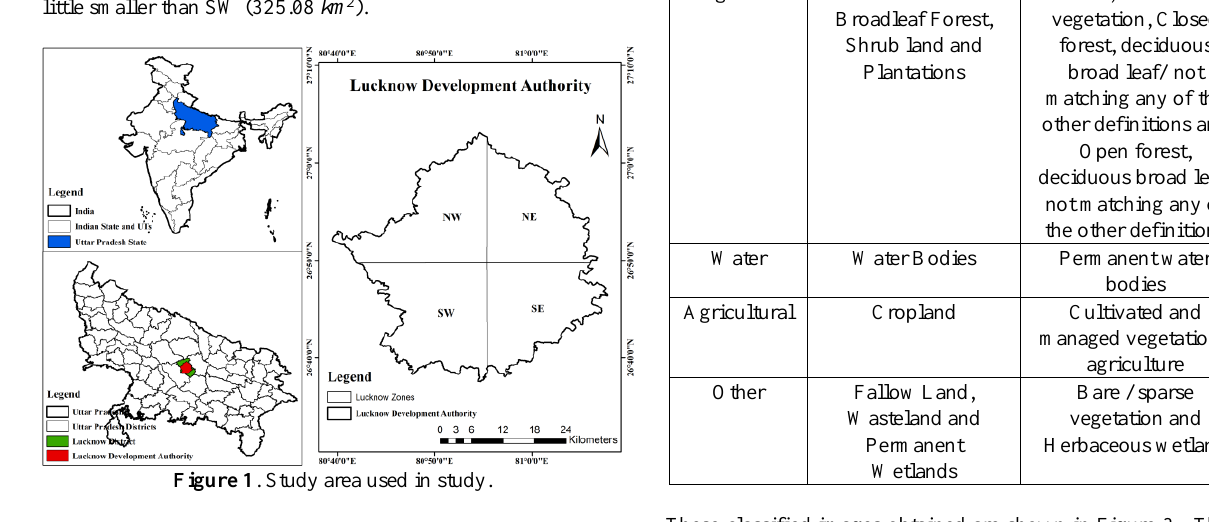
Figure 1 . Study area used in study.